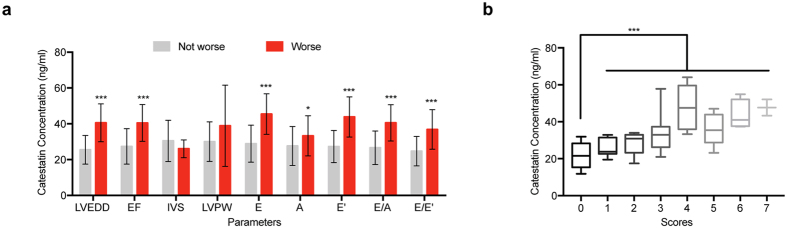
(a) Histograms showing the comparison of catestatin concentrations at D3 between “Worse” group and “Not worse” group. (b) Patients were stratified according to different scores, and catestatin concentrations were compared between these groups. Whiskers denote the minimal value and max value. Error bars, SD. *p < 0.05, **p < 0.01, ***p < 0.001.